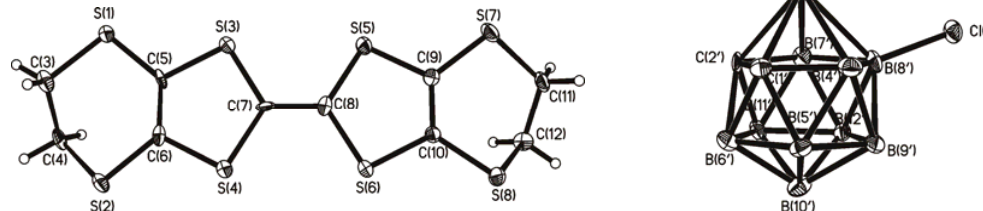
Figure 1. Atom designations in (BEDT-TTF)[8,8',(7)-Cl (1',2'-C